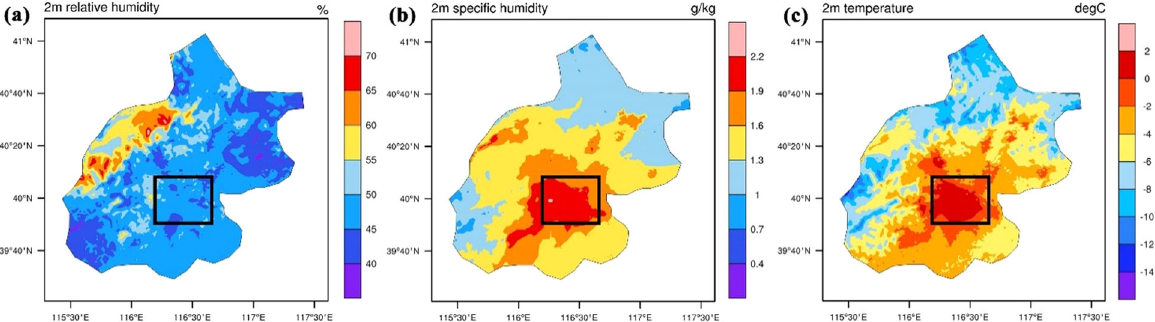
Fig. 3 Beijing experiences a wet island effect during winter. Average winter simulation results (48 h average values) for ( a ) 2 m relative humidity (%), ( b ) 2 m air speci fi c humidity (g kg − 1 ), and ( c ) 2 m air temperature